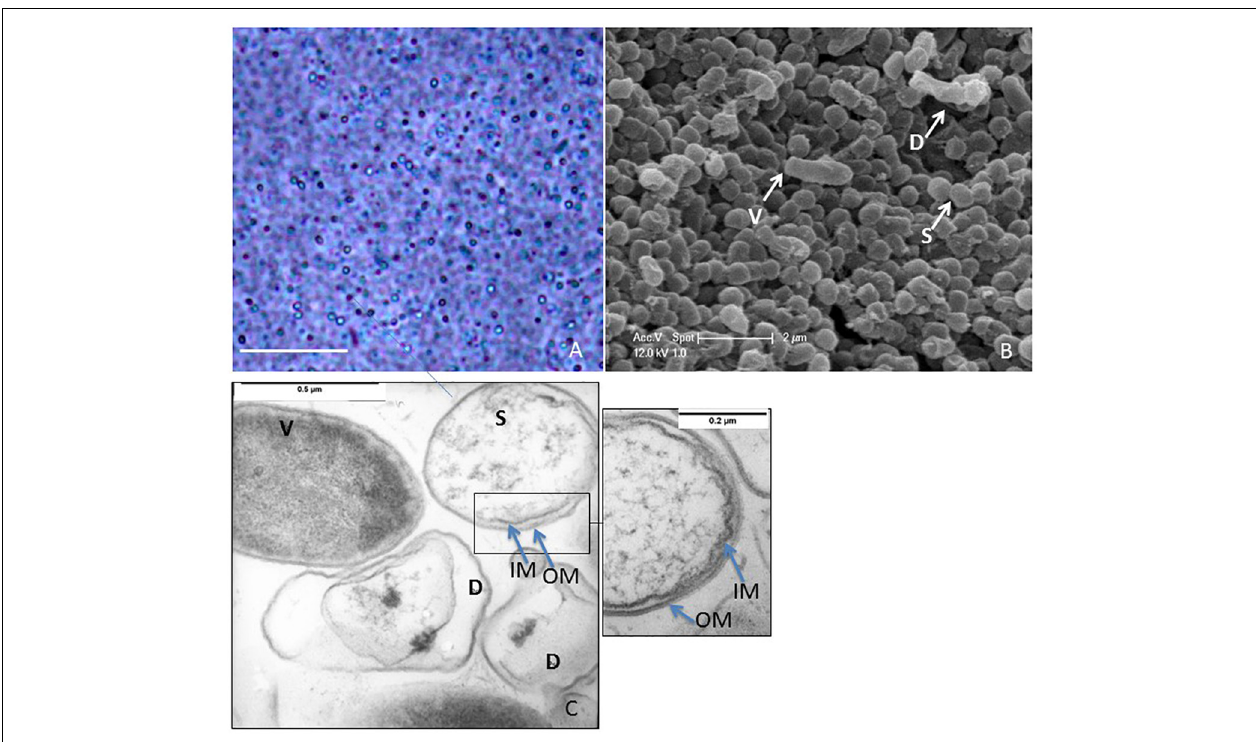
FIGURE 2 | (A) Phase contrast microscopy of a 2-month old culture of Lr5/4. Phase bright objects of different sizes, are surrounded by lysed cells. Bar = 10 µ m. (B) Scanning electron microscopy of vegetative (V), lysed (D), and dormant (S) cells. (C) Transmission electron microscopy (TEM) of vegetative (V), lysed (D), and dormant (S) cells. Noticeable black spots inside the lysed cells. Dormant cells are clearly shown to be double-membraned (see also